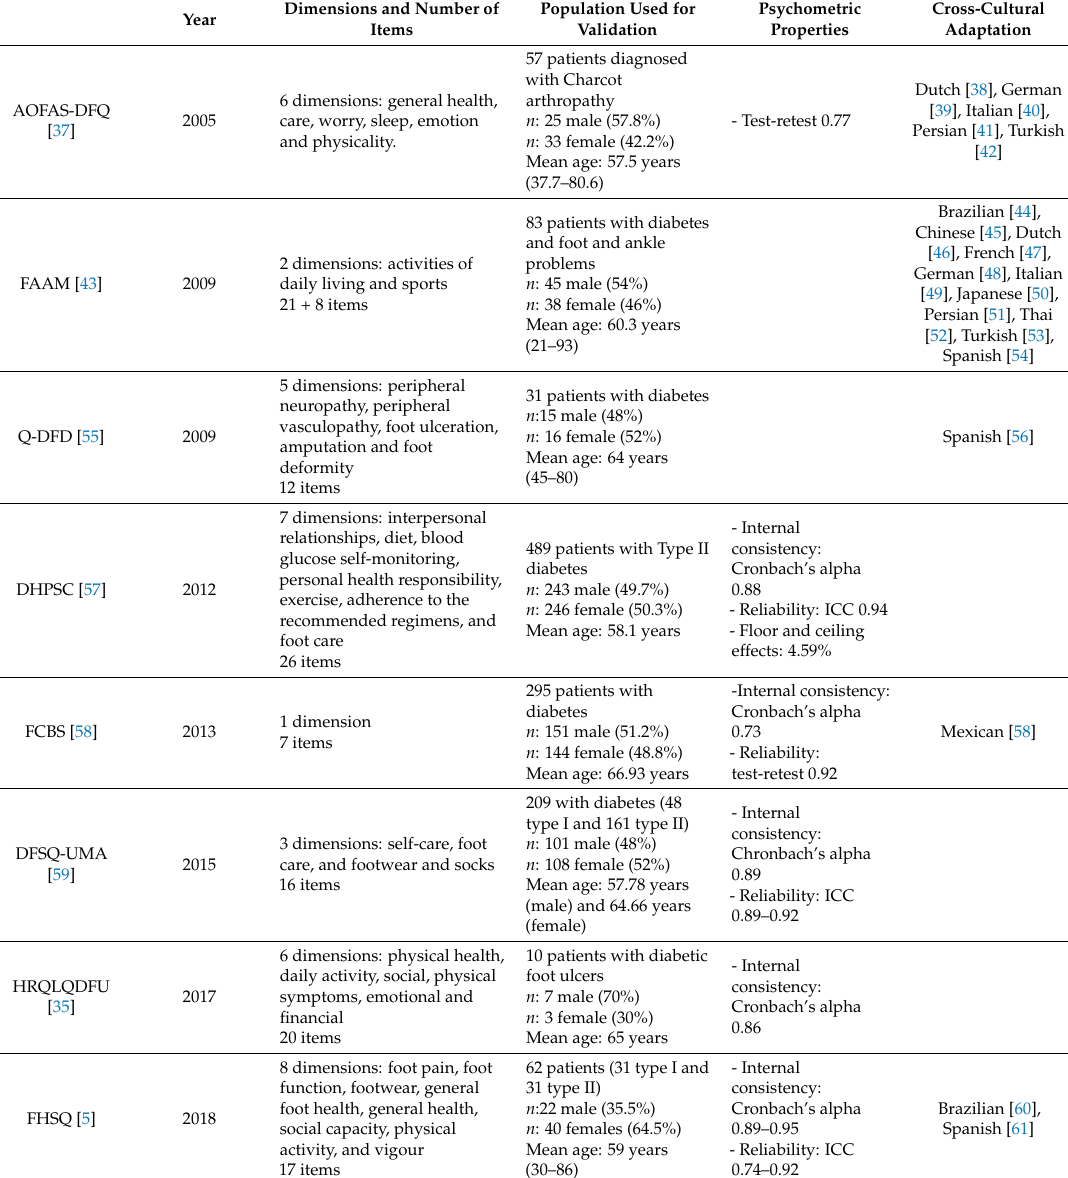
Population Used for Validation